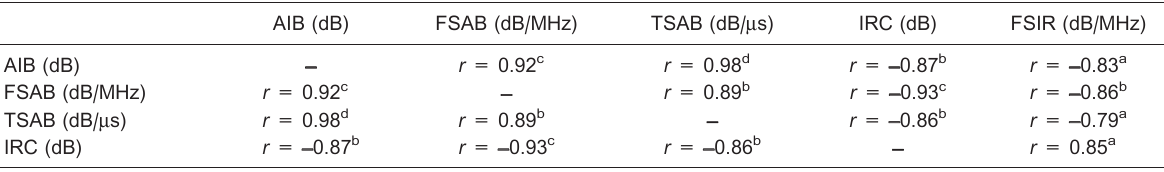
Table 2. Pearson’s correlation coefficient ( r ) of parameters and P for Experiment